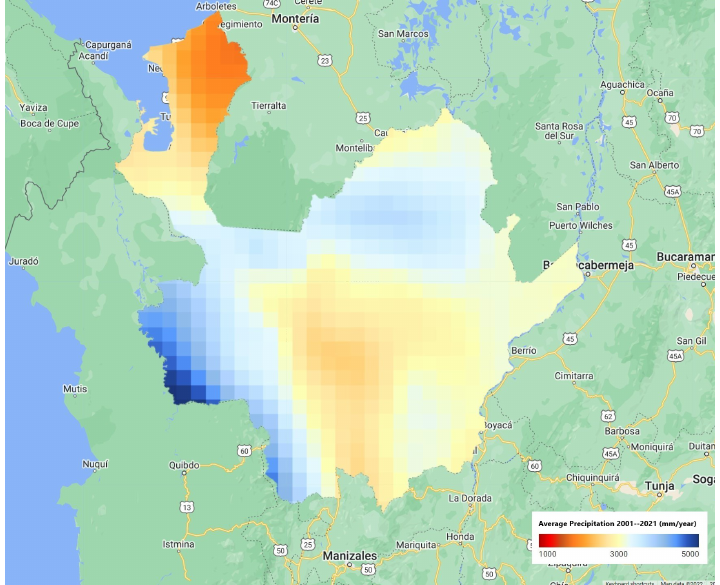
Figure 5. Precipitation values in Antioquia Department, Colombia by the Precipitation Es- timation From Remotely Sensed Information Using Artificial Neural Networks-Climate Data Record (PERSIANN).